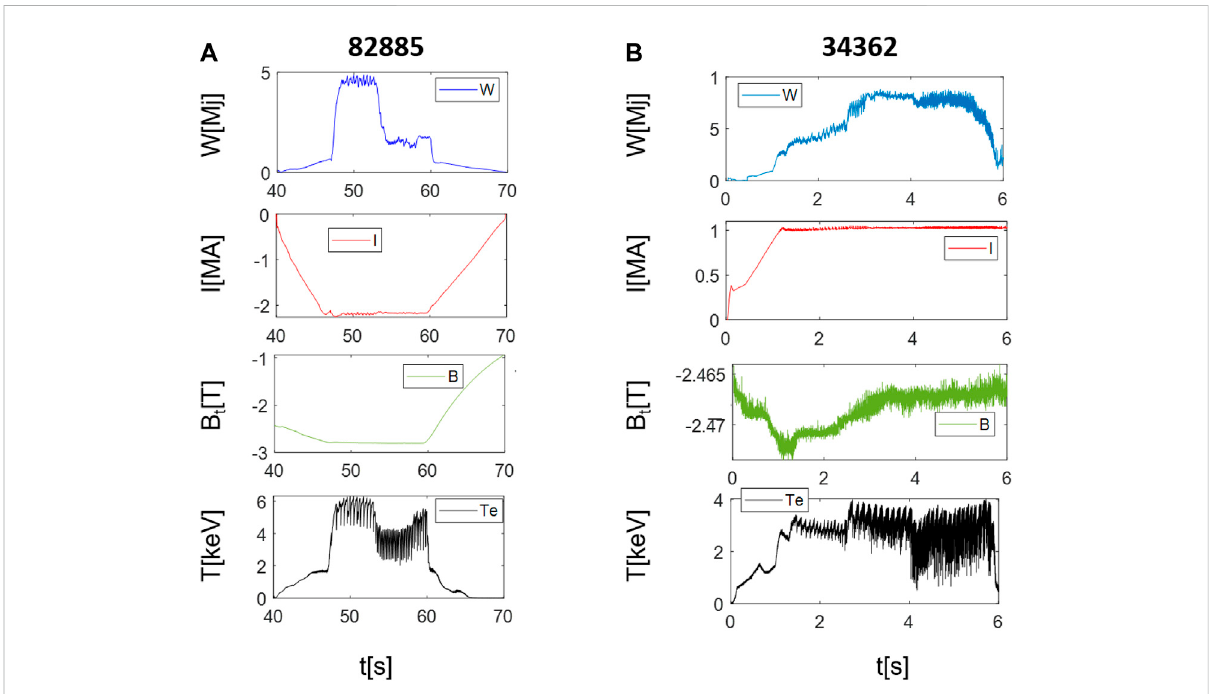
FIGURE 7 Typical examples of experiments devoted to ELM pacing with pellets. (A) JET and AUG (B) . From top to bottom: plasma internal energy, plasma current, toroidal fi eld, central electron